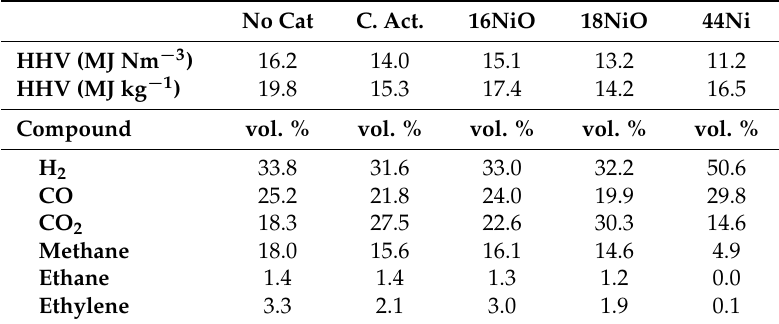
Table 4. Gases chromatography analysis (vol. %) and